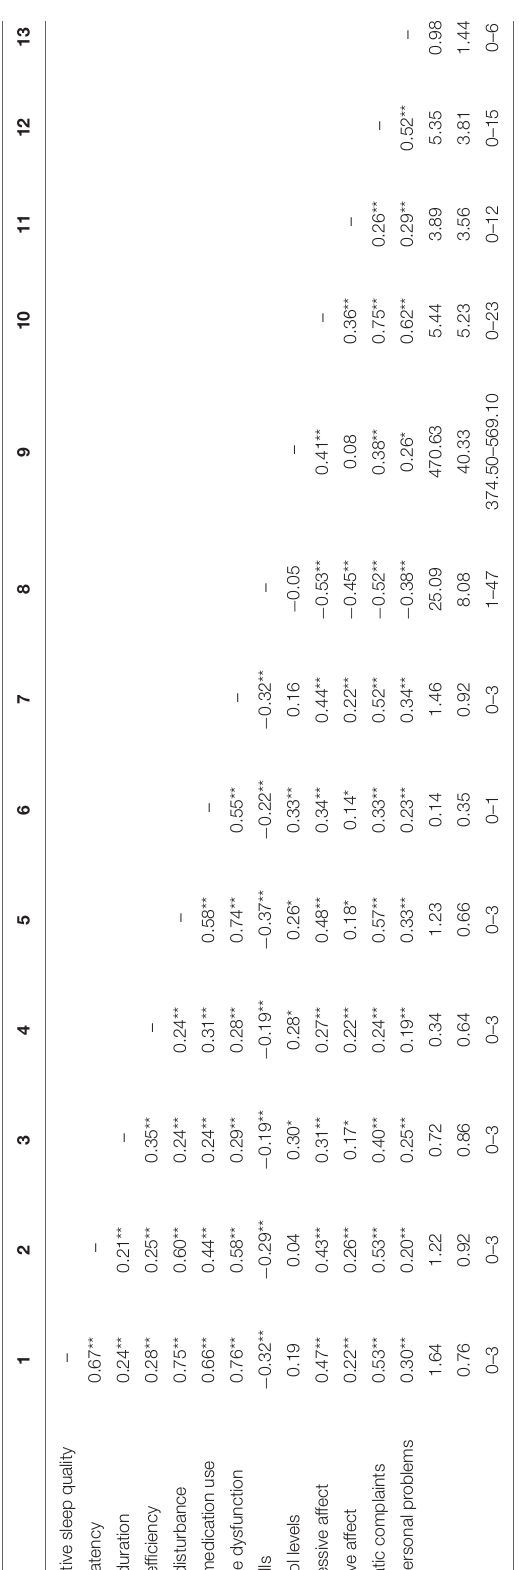
Depressive Symptoms For moderation analyses with the dependent variable CES- D total , a significant interaction was found for sleep quality and cortisol levels ( (cid:49) R 2 = 0.07; (cid:49) F 1 , 61 = 8.23; p = 0.006; b = 0.27; t = 2.87; p = 0.006), suggesting that the positive relationship between sleep quality and depressive symptoms was intensified by higher cortisol levels. However, when the centered and logarithmized cortisol values are less than the threshold of − 0.55, the moderating effect of cortisol levels on the relationship between sleep quality and depressive symptoms is not